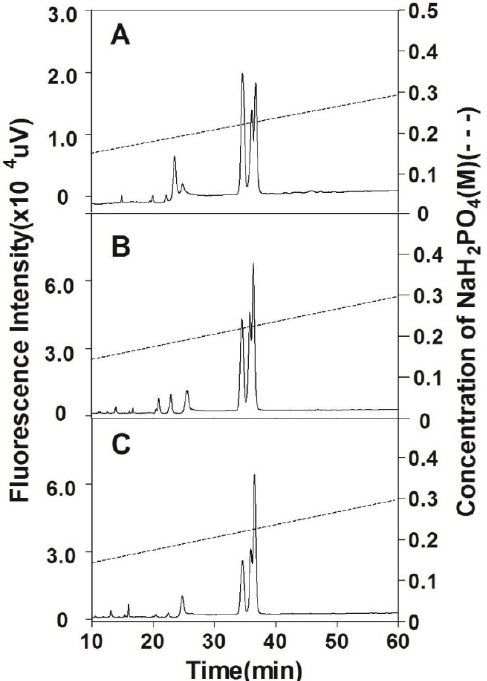
Figure 8. Analysis of hexasaccharide fractions by anion-exchange HPLC. The hexasaccharide fractions prepared from SHCS ( A ), SBCS ( B ), and SFCS ( C ) were analyzed as described in the caption of Figure 5. All samples were analyzed by HPLC on a YMC-Pack PA-G column using a NaH 2 PO 4 gradient (indicated by the dashed line).